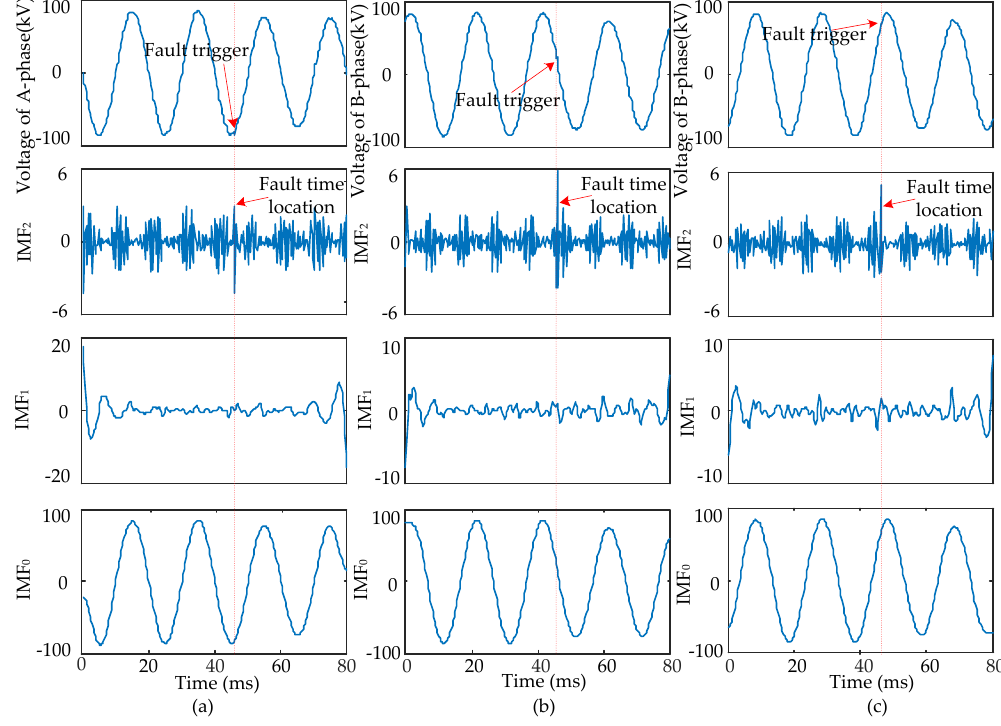
Figure 16. Actual ABC fault signal’s modes extracted by the EWT are shown as follows: ( a ) A-phase voltage and its IMFs; ( b ) B-phase voltage and its IMFs; ( c ) C-phase voltage and its IMFs.